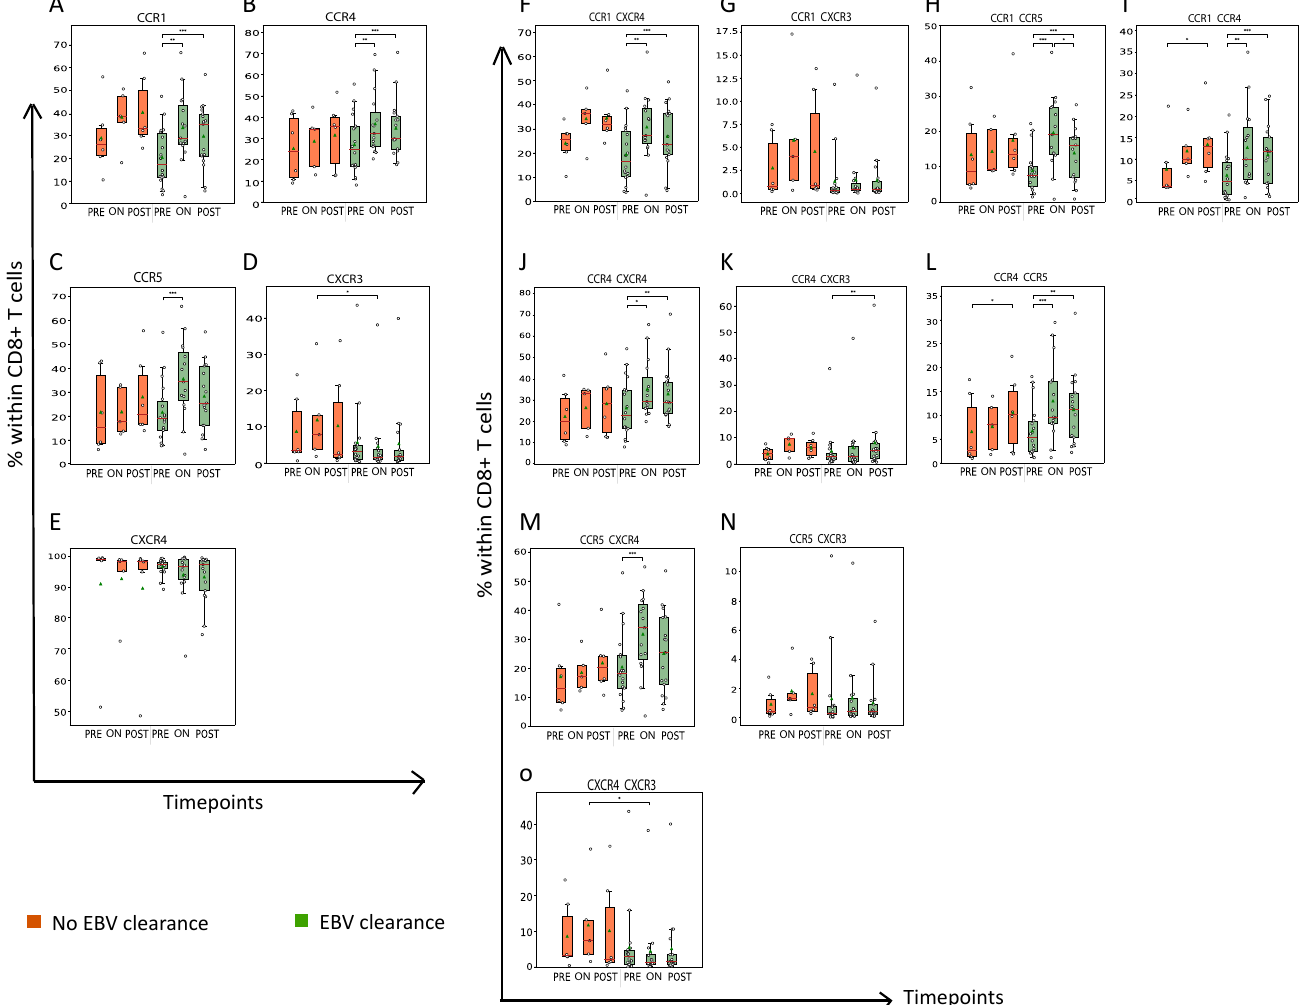
Figure 5. Plasma EBV DNA clearers demonstrate early increase in frequency of CCR1-, CCR4- and/or CCR5-expressing CD8+ T cells during RT. Boxplots displaying frequency of CD8+ T cells expressing Figure 5 : Plasma EBV DNA clearers demonstrate early increase in frequency of CCR1, CCR4 and/or CCR5-expressing CD8+ T cells during ( A – E ) a single type or ( F – O ) two different types of chemo-attractant receptors. Details regarding RT. display of patient groups, time points and statistical analyses are described in legend to Figure 2. * p < 0.05, ** p < 0.01, *** p <